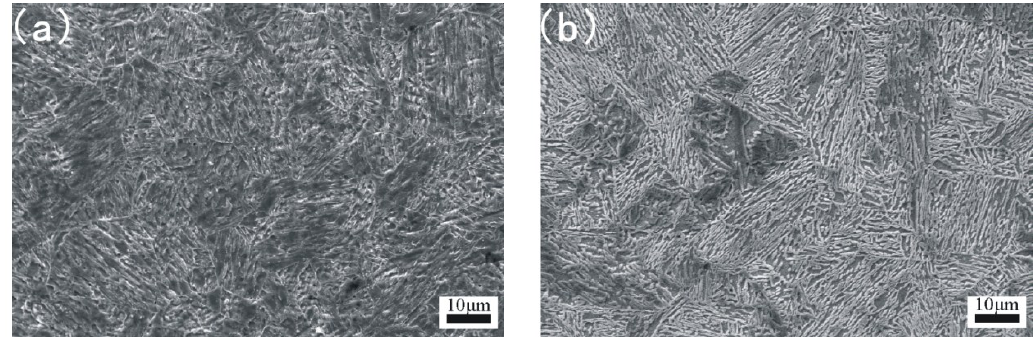
Figure 3. Scanning electron microscope (SEM) image of HAZ and base metal: ( a ) HAZ; ( b ) base metal.